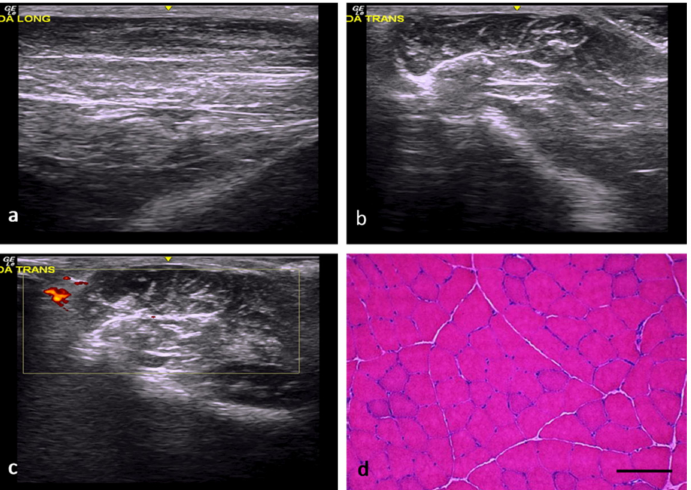
Figure 1. NC group. ( a ) Normal muscle echostructure along the longitudinal axis, compris- ing a hypoechoic background with numerous hyperechoic lines corresponding to the perimysial septa. ( b ) Normal muscle echostructure along the transverse axis, with a predominantly hy- poechoic background with small, interspersed hyperechoic lines and dots corresponding to the perimysium. ( c ) Transverse section assessed by power Doppler imaging, with images of scarce vas- cularization in the surrounding connective tissue. ( d ) Transverse section representative of the muscle histology. H-E. Size scale: 100 µ m.